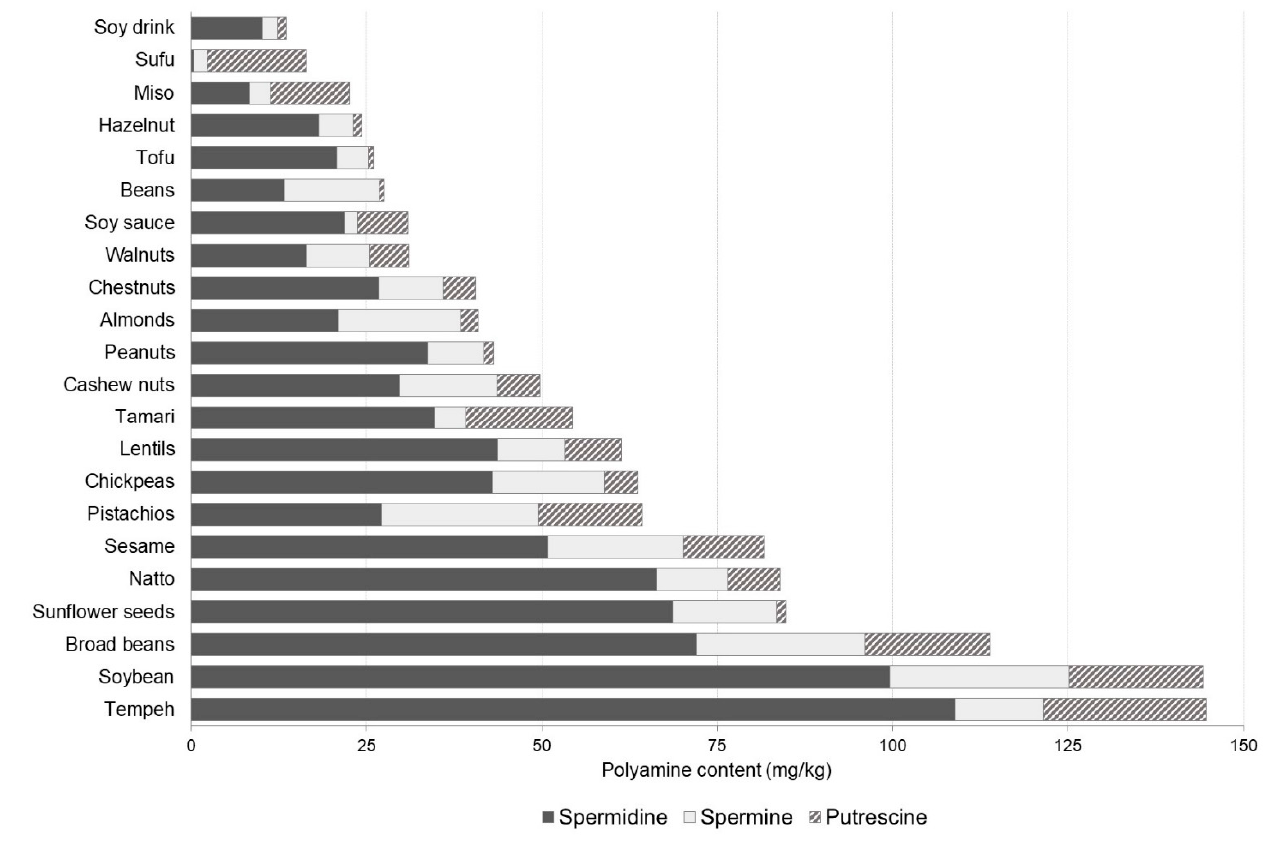
Figure 5. Polyamine profile and content (mg/kg) in legumes, nuts and seeds. In foods of an animal origin (meat, fish and dairy products), the total polyamine content was highly variable with values ranging from 0.15 mg/kg to 139 mg/kg (Figure 6). The highest levels were found in a few types of cheese (raw milk, hard and blue cheese) and dry-fermented sausages; products with an elevated content of putrescine arising